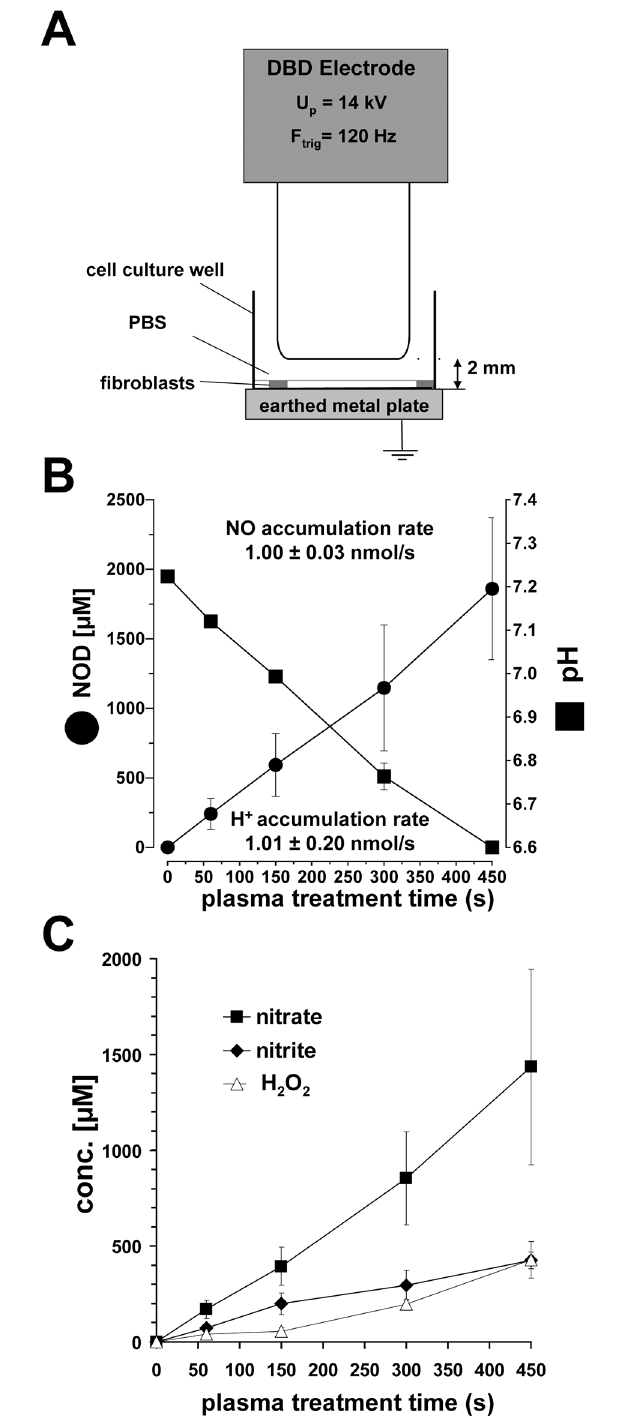
Fig 1. DBD-induced acidification and accumulation of nitrite, nitrate and hydrogen peroxide. A Experimental set-up for DBD treatments of fibroblasts. B Amounts of NOD (nitrite + nitrate) and pH values obtained after DBD treatment times as indicated. Given are the mean ± sd values (n =